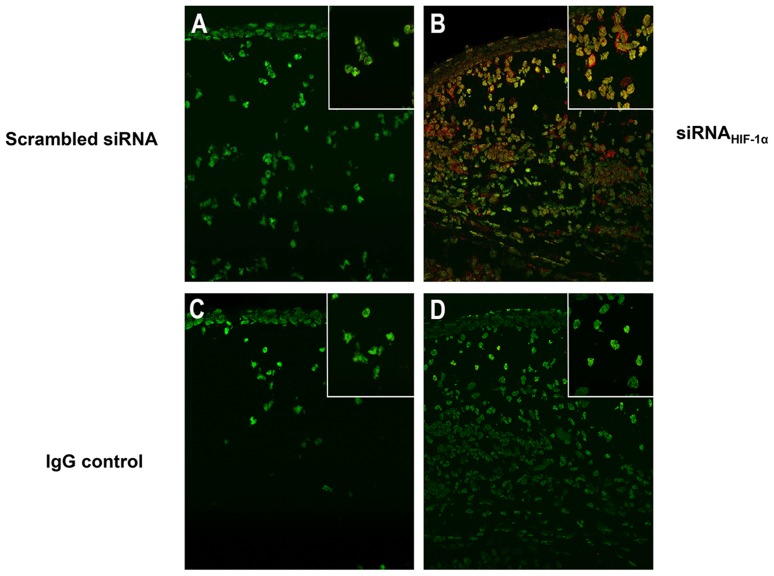
Immunostaining of T cell infiltrate after siRNAHIF-1α treatment.No positive immunostaining for CD3ε, a pan T cell marker, was detected in the corneas of scrambled siRNA-treated mice (A) at 5 days p.i. In contrast, positive immunostaining (red) was observed in the peripheral cornea of HIF-1α silenced animals (B). The control sections shown in (C) and (D) were immunostained with species-specific IgG and were positive for SYTOX Green nuclear stain only. Images shown are representative of three independent experiments each with three mice per group. Magnification = 180×; inset = 335×.